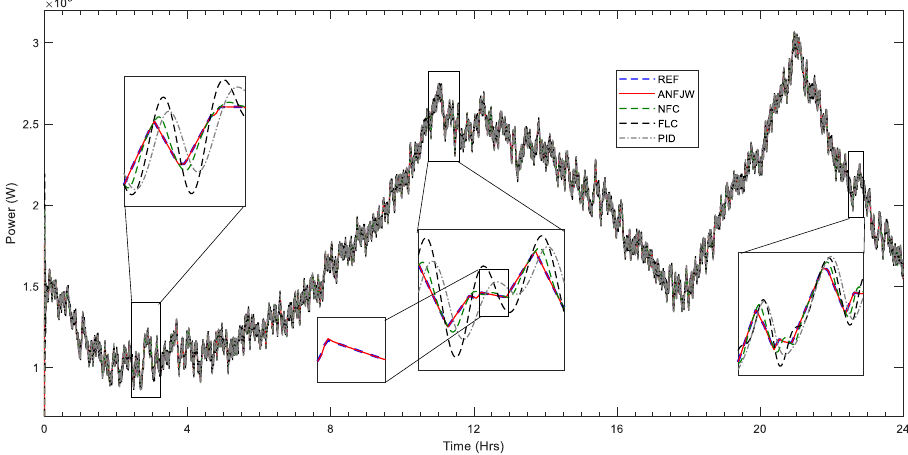
Figure 13. Output real power comparison at different intervals.